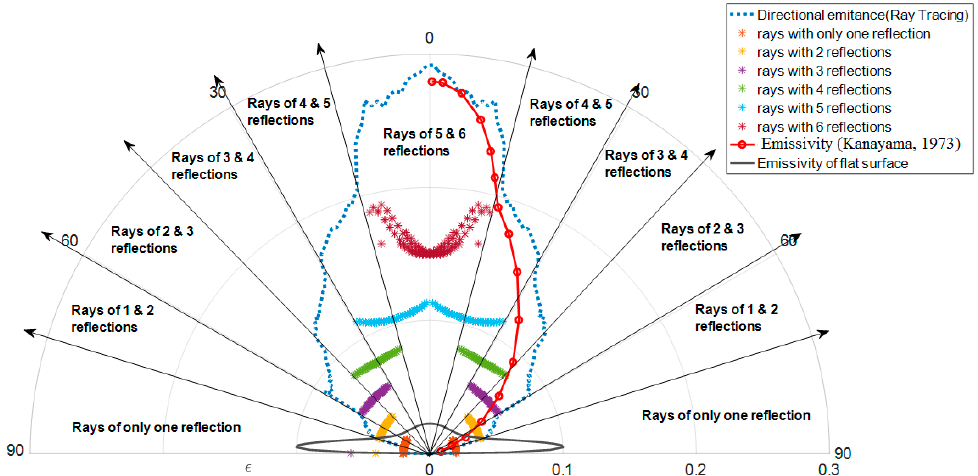
Figure 10. Total apparent directional emissivity of a V-groove and a flat aluminum surface in the infrared range compared to [12].